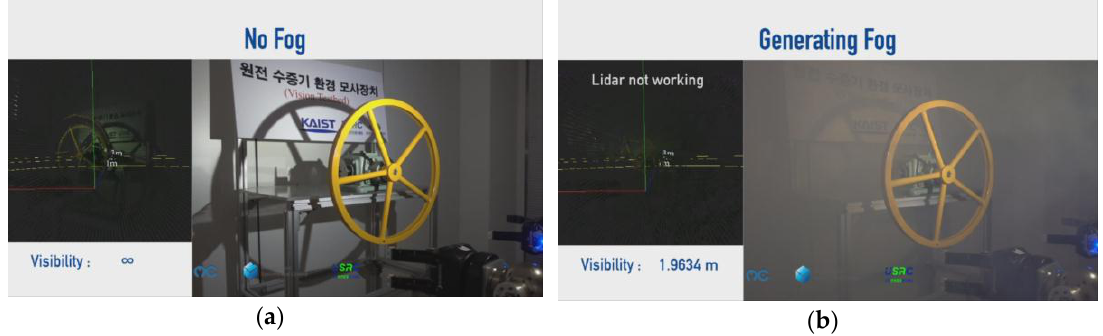
Figure 10. Experiment environment of valve turning manipulation in foggy condition.